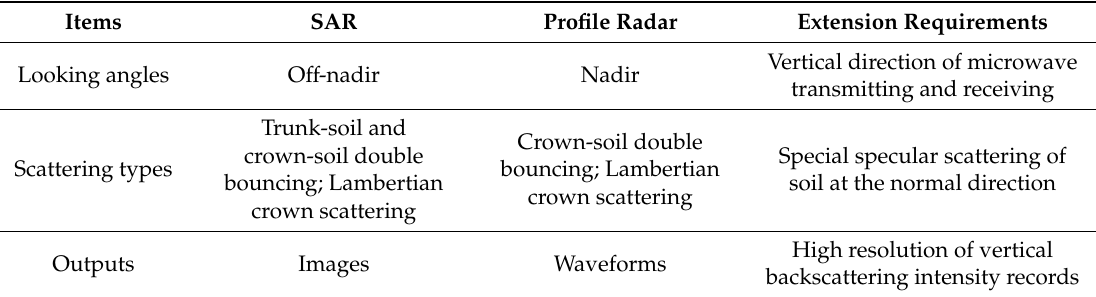
The di ff erence between synthetic aperture radar (SAR) and profile radar and the